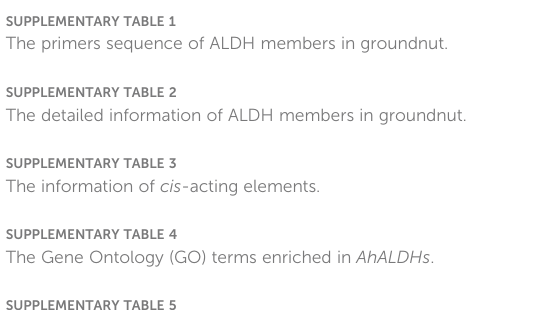
SUPPLEMENTARY TABLE 3 The information of cis -acting elements. SUPPLEMENTARY TABLE 4 The Gene Ontology (GO) terms enriched in AhALDHs . SUPPLEMENTARY TABLE 5 The Kyoto Encyclopedia of Genes and Genomes (KEGG) pathways enriched in